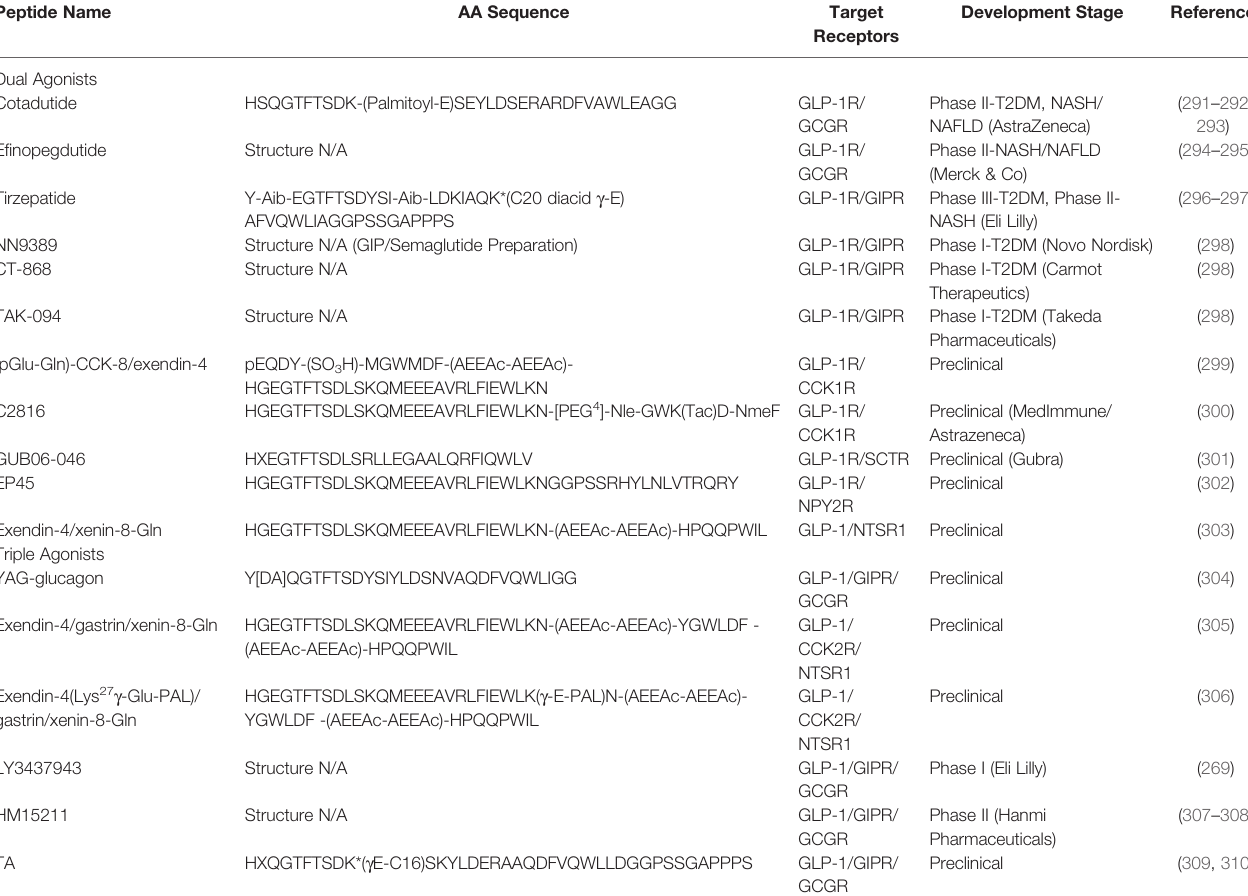
TABLE 5 | Multiagonists based on proglucagon-derived peptides in